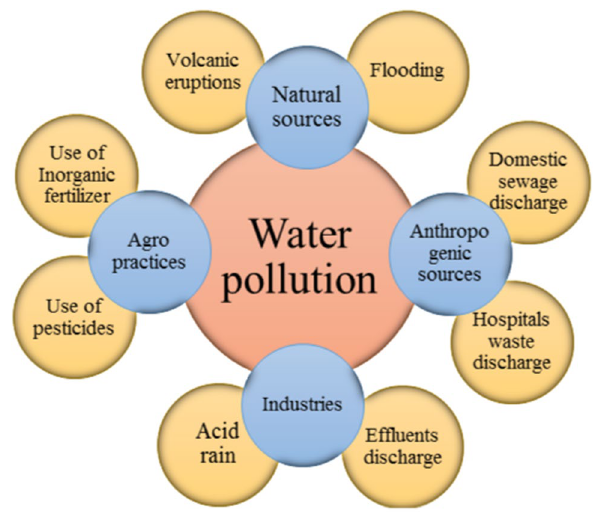
Fig. 2 Different sources of water pollution in